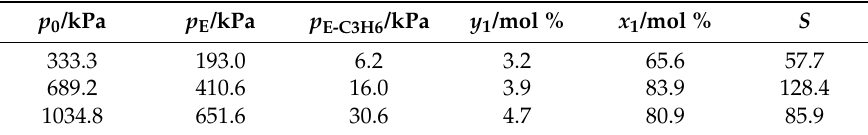
Table 3. Separation results for C 3 H 6 (1) + H 2 (2) gas mixture ( z 1 = 0.35) by using ZIF-8/water-glycol slurry where the mass ratio between water and glycol in liquid was specified to 4:1 with 20 wt % ZIF-8 at 293.15 K and different initial pressures.